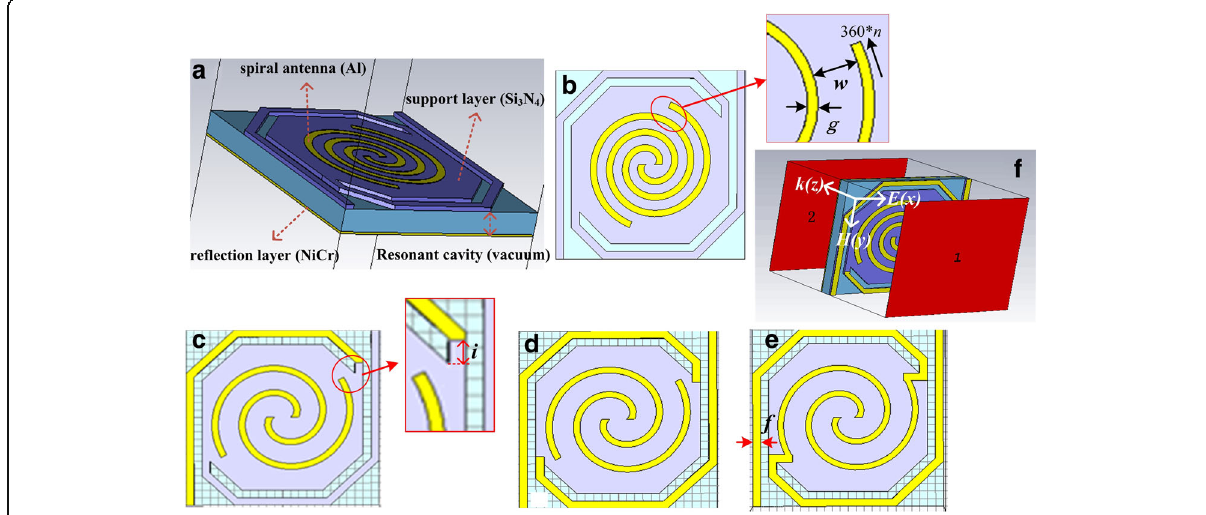
Fig. 1 Design of spiral-type antenna-coupled micro-bridge structures. a Model of micro-bridge structure. b Spiral-type antenna on the support layer. c Spiral-type antenna with a single separate linear antenna on one of the bridge legs. d Spiral-type antenna with two separate linear antennas on the bridge legs. e Spiral-type antenna with two connected linear antennas on the bridge legs. f Directions of electric field and